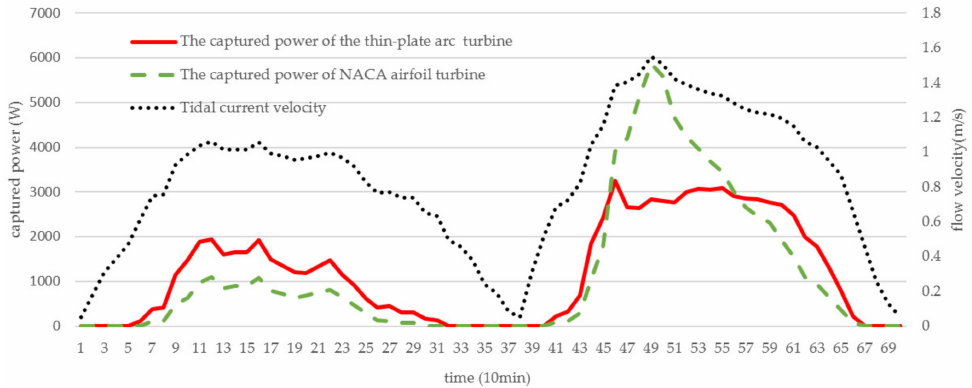
Figure 19. Capture-power and flow-rate graphs of the tidal